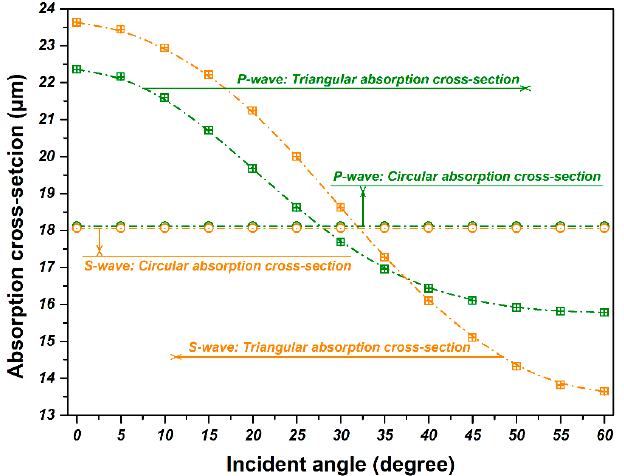
Figure 7. The absorption cross-section of circular and triangular fibers at different incidents. The characteristic diameter d c is 20 μ m and the wavelength 9.34 μ m.